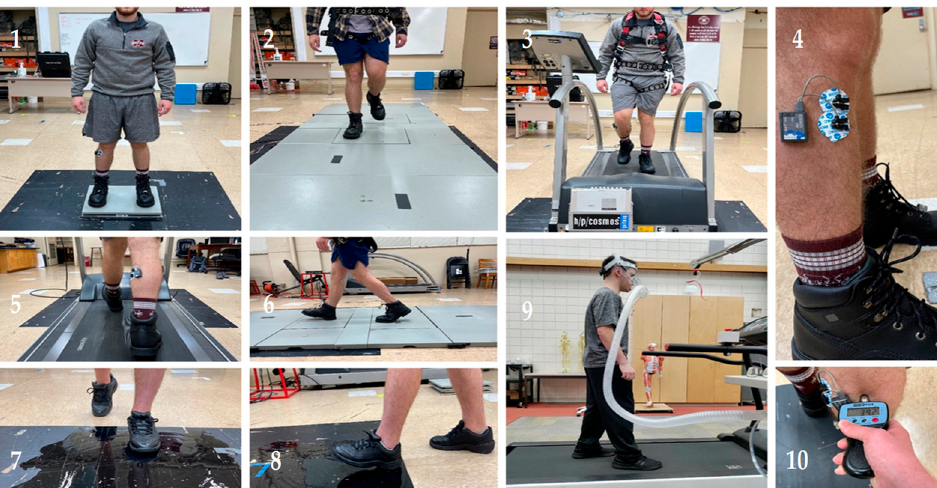
Figure 2. Biomechanics and physiology tests performed with occupational footwear. Various bio- mechanical and physiological human factors assessment in occupational footwear. ( 1 ) Static balance and postural stability, ( 2 ) Overground gait trials, ( 3 ) Treadmill gait trials, ( 4 ) Electromyography (EMG) from lower extremity muscles (tibialis anterior), ( 5 ) Treadmill workload used for fatigue in- duction with EMG (gastrocnemius pictured), ( 6 ) Overground dry surface gait trials, ( 7 , 8 ) Over- ground slippery surface gait trials, ( 9 ) Energy expenditure during treadmill workload, ( 10 ) Pressure pain threshold (PPT).